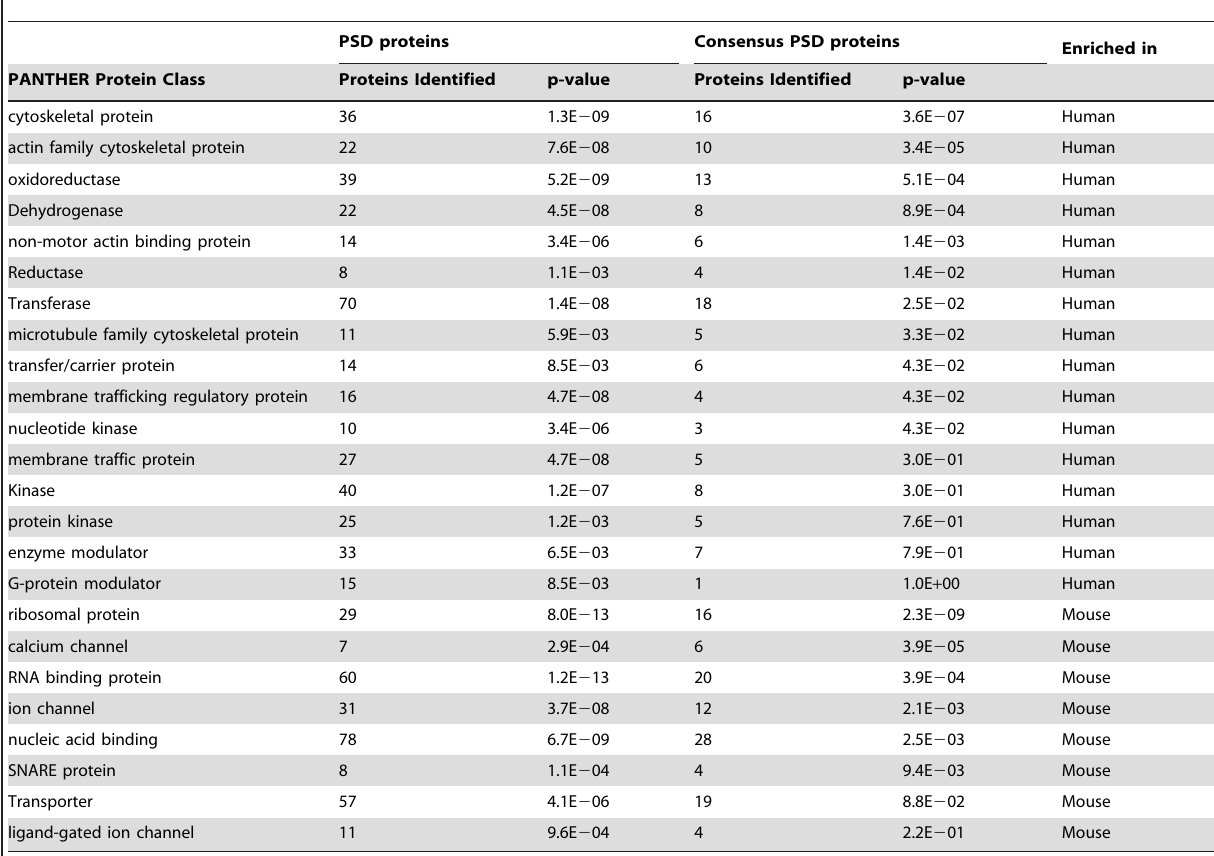
Table 1. Significantly enriched protein classes of species-specific PSD